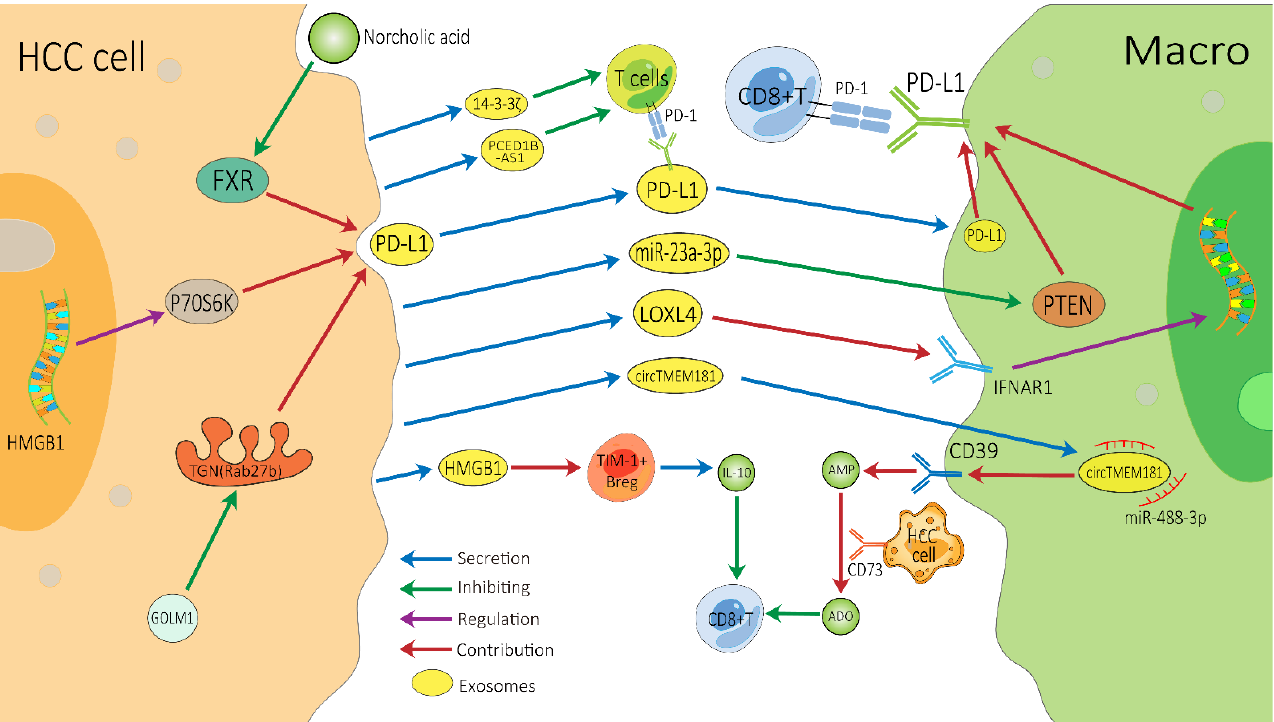
Figure 2. Possible exosome-associated resistance mechanisms for immunotherapy of HCC. TEXs